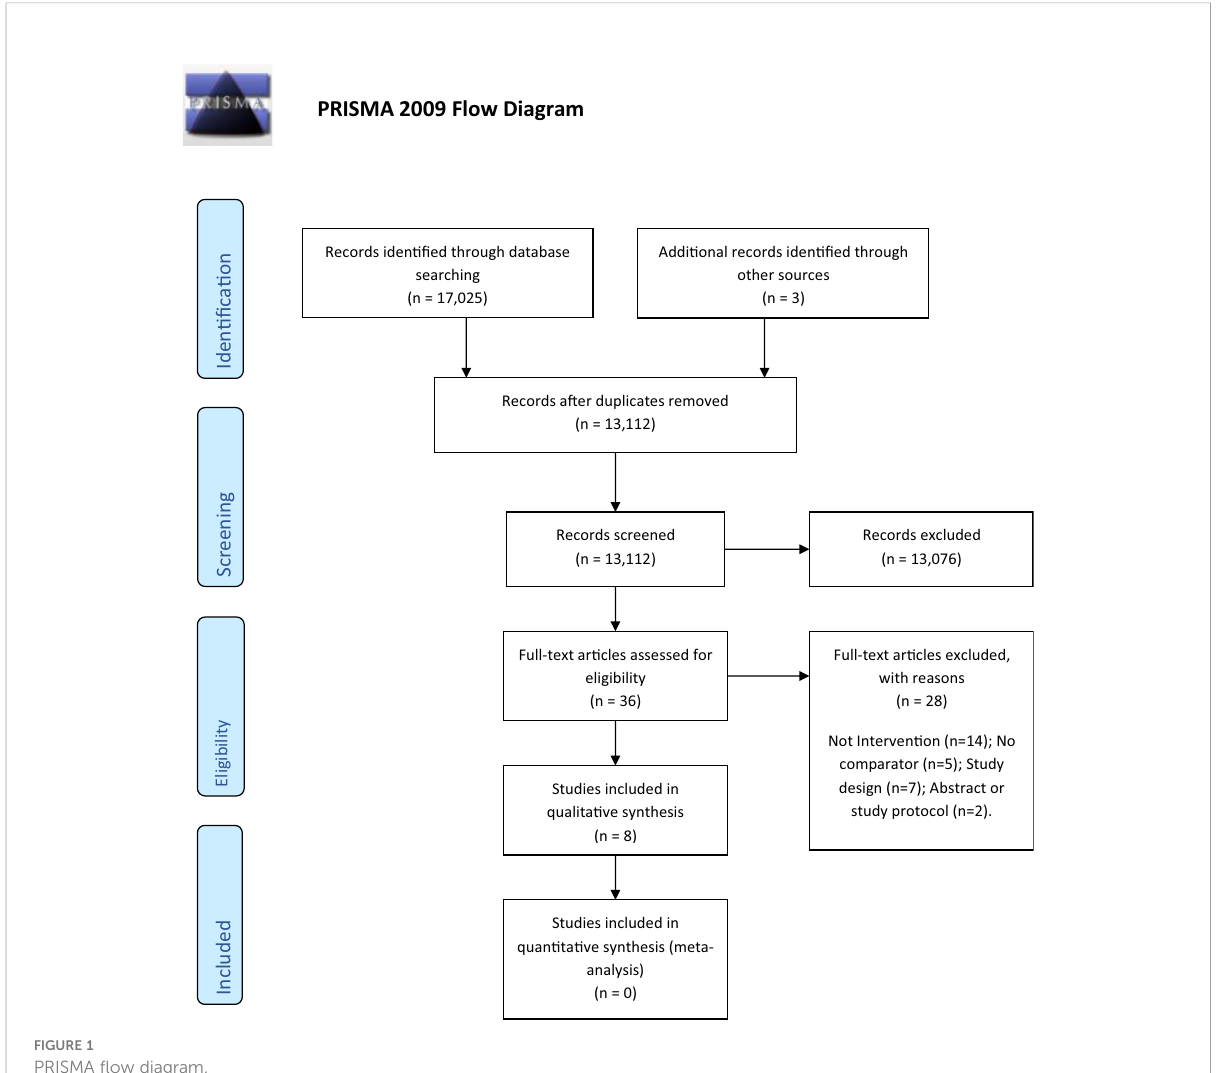
FIGURE 1 PRISMA fl ow